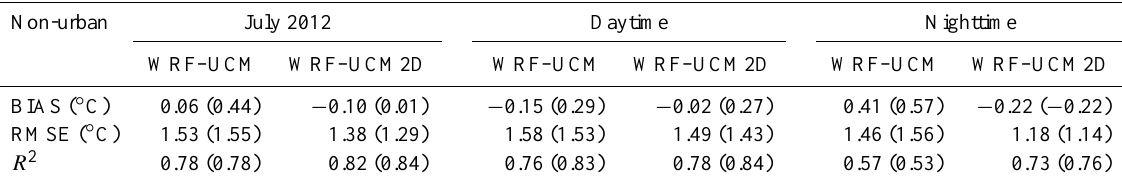
Figure 8. Difference between simulated and observed diurnal variation in temperature at non-urban stations (a) C0AD20, (b) C0A640, and (c) C0D360. Table 3. Bias, RMSE, and R 2 calculated using simulated temperatures at 21 non-urban stations for the month of July 2012, for daytime, and for nighttime obtained by WRF–UCM and WRF–UCM2D. The numbers in parentheses were analysis results after the exclusion of model data where simulated rainfall was found to be